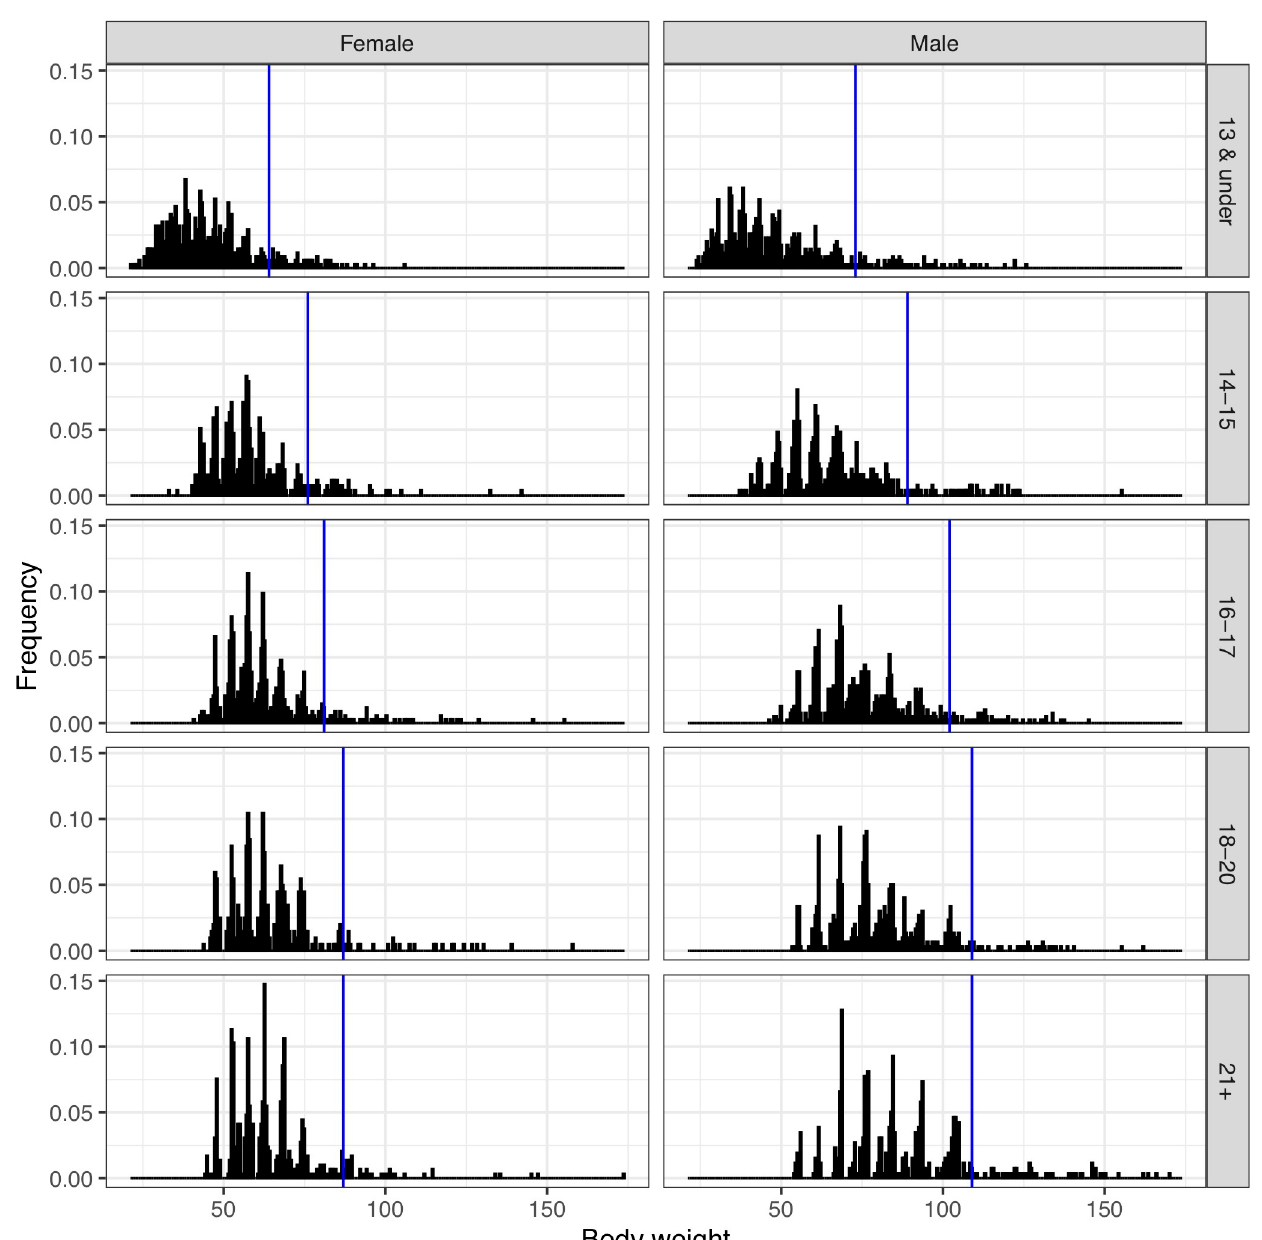
Fig 3. Histogram of body weights in different age groups. Lines indicate the unlimited upper body weight class. and 25, respectively, at the 90 th percentile. At 69kg body mass the sex-related performance dif- ference increases from 12.8% at age 10 to 22.9% at age 17. At age 25 men outperform women by 23.6% at 69kg body mass and by 29.9% at 81kg body mass (Fig 5). Age at peak performance Women reach the peak performance at a younger age than men at the 90 th percentile (p < 0.001). The age at peak performance for men at the 90 th percentile is 26.5 (95% CI: 25.7,